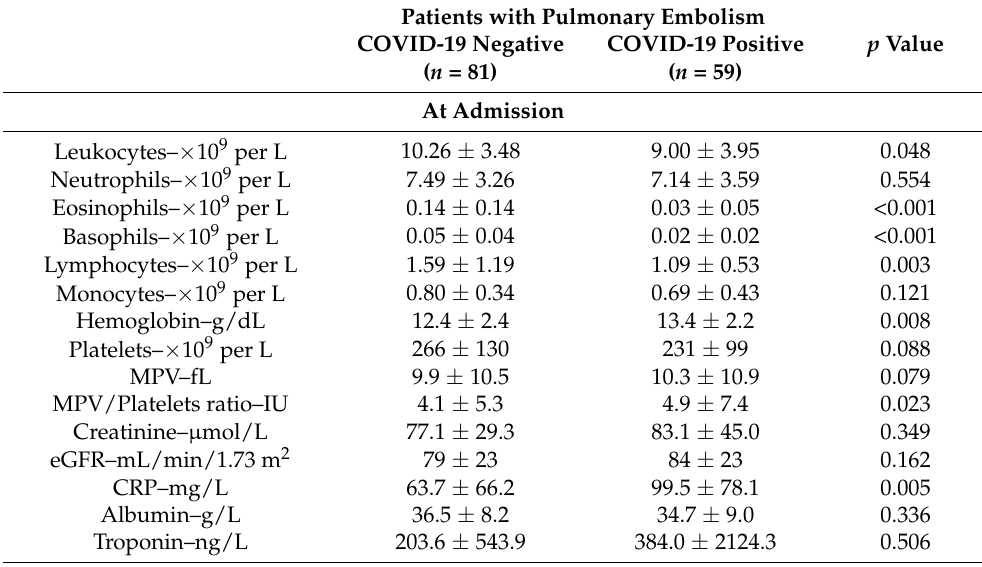
Figure 2. Examples of CTPA of COVID-19 patients with acute pulmonary embolism (lung windows: ( A , C ); mediastinal windows: ( B , D )). Red arrows show lobar and segmental thrombus within the pulmonary vasculature. Green dots: areas with COVID-19 related parenchymal injuries. Abbreviations: COVID-19, coronavirus disease 2019; CTPA, computed tomography pulmonary angiography. Table 3. Laboratory findings at admission, during hospitalization, and at